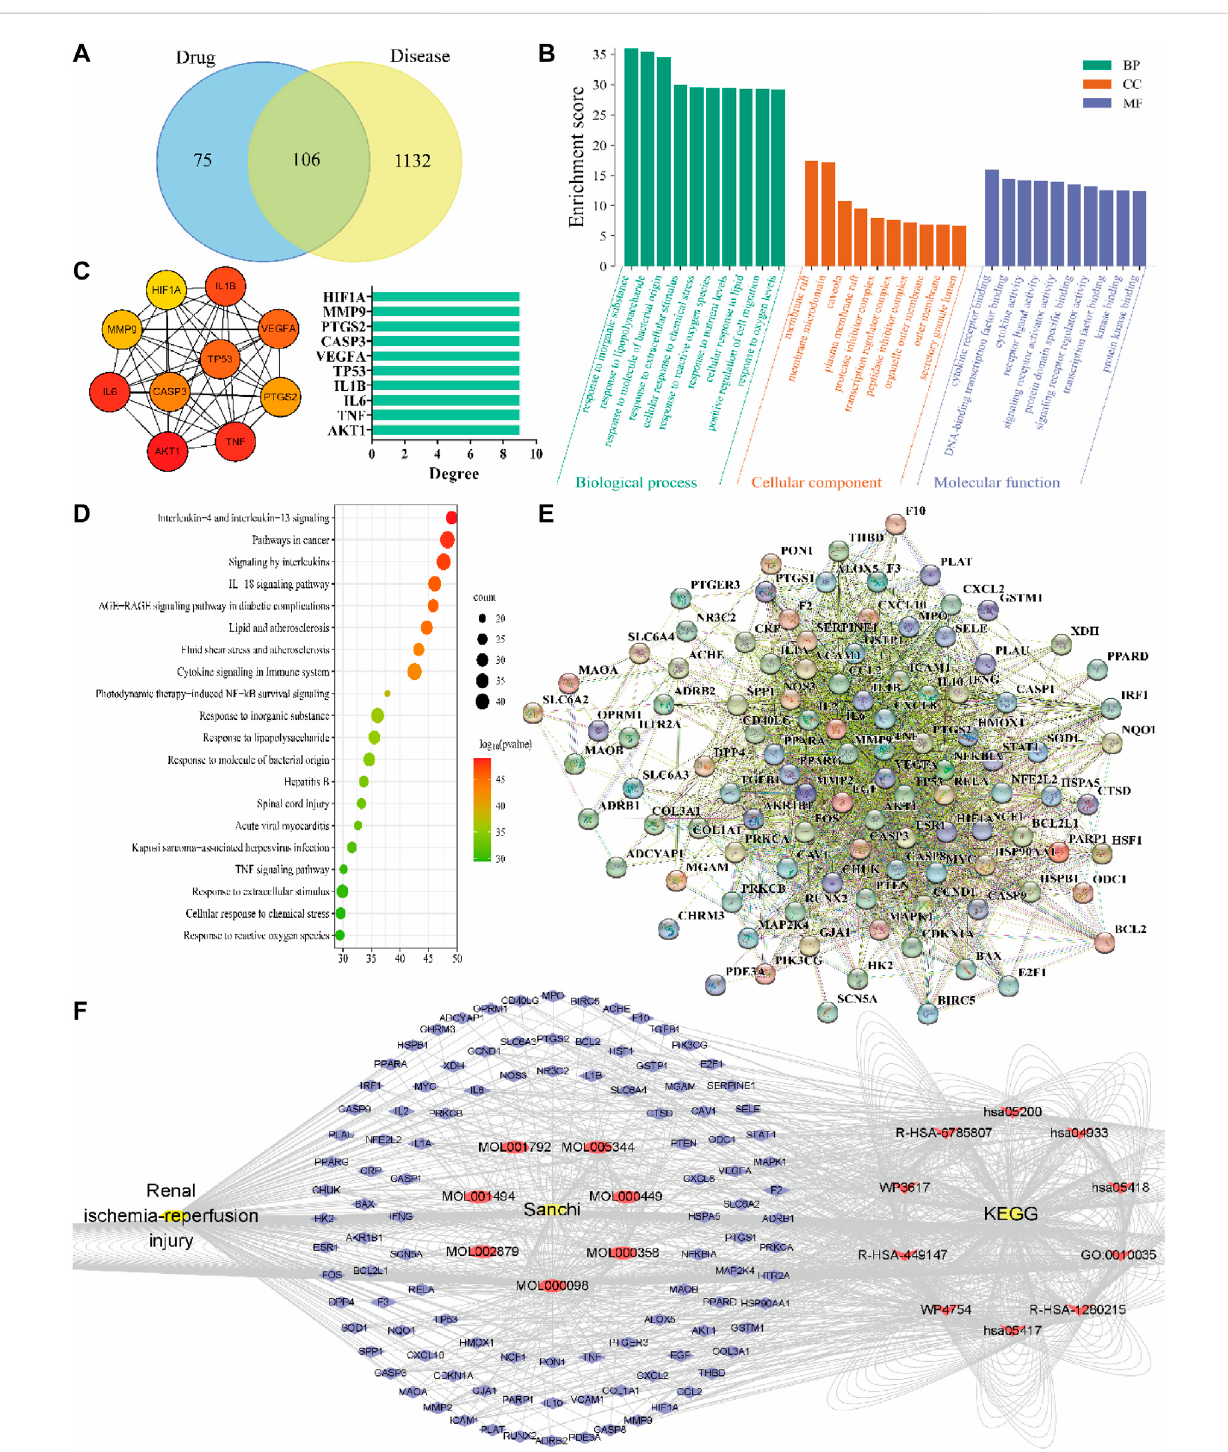
FIGURE 3 Resultsofdrug-disease networkrelationshipanalysisusingnetworkpharmacologymethods. (A) Drug-diseaseVennyintersectiondiagram,withthe drug(Sanchi)targets ontheleft,thedisease(RIRI)targetsontheright,andthetwointersectiontargetsinthemiddle; (B) GOenrichmentanalysisofdrug- disease; (C) HubgenesscreenedaccordingtothePPInetworkrelationshipsandroundedfromthelargesttosmallestwiththeDegreevaluechanges,and Degree – hub genes histogram with the Degree values as horizontal coordinates and genes as vertical coordinates; (D) KEGG signaling pathway analysis of drug-disease; (E) PPI network relationship diagram; (F) The network of “ disease-drug active ingredient-key target-KEGG signaling pathway ” , fromlefttoright,isthedisease(RIRI),drug(Sanchi)anditsseven activeingredientsMolnumbers,keytargets(blueoutercircle),andthe fi rsttenpathways of